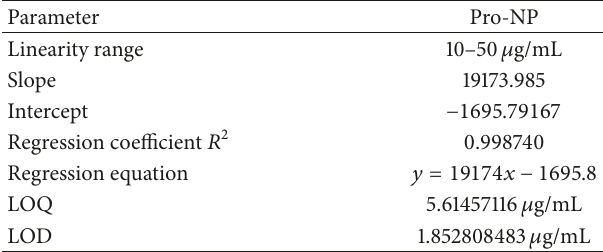
Table 3: Data from the regression